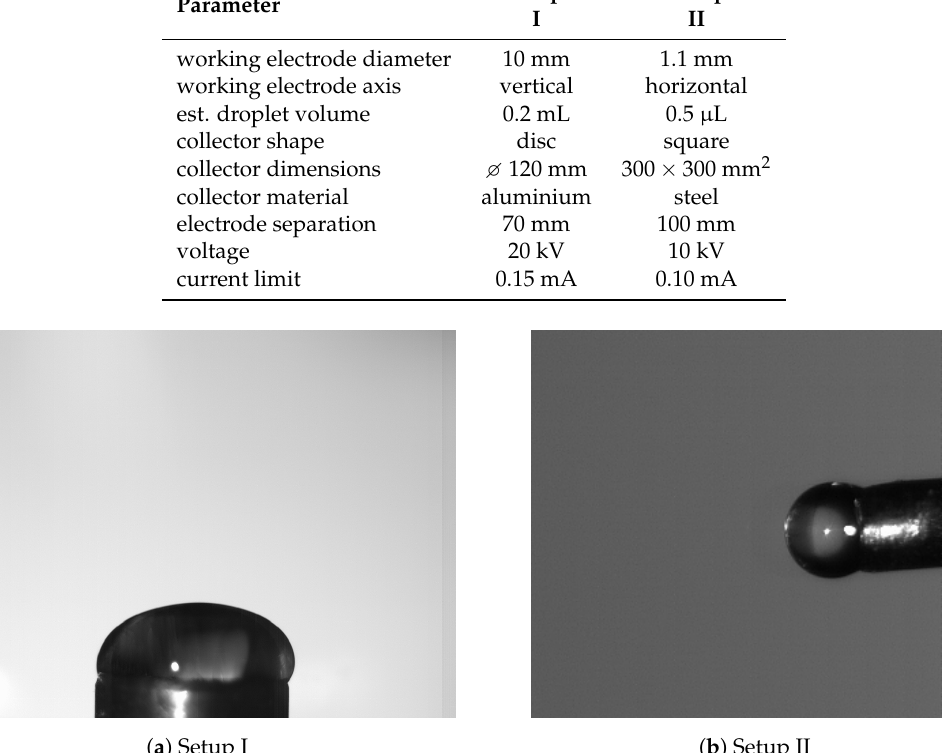
Figure 5. Photographs of initial droplets, just before the electric field was applied. ( a ) A droplet at vertical working electrode in setup I. ( b ) A droplet at horizontal working electrode in setup II. Photographs were exported from the record of the Olympus i-SPEED 720 high-speed camera using i-SPEED Software Suite